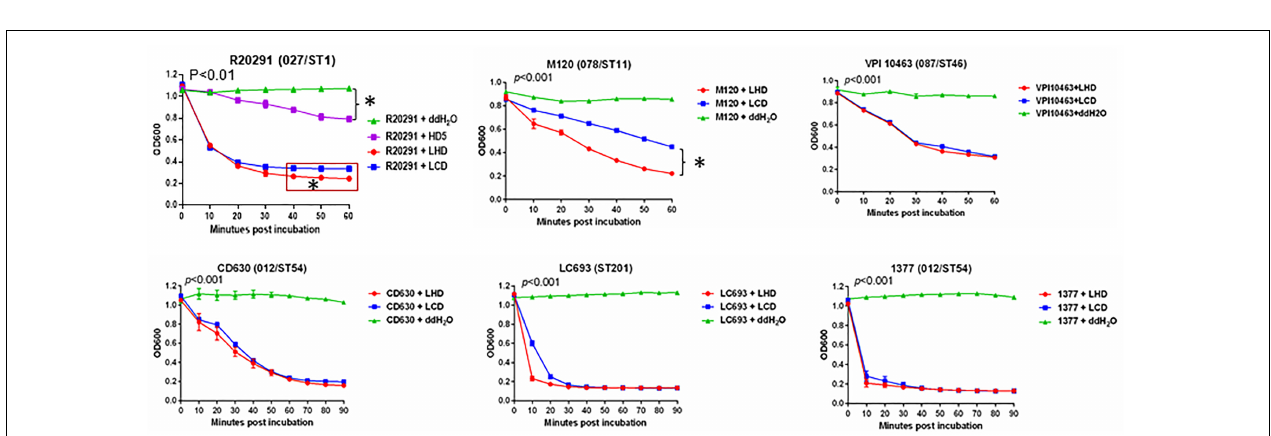
FIGURE 2 | Purification of protein LHD and LCD. (A) SDS-PAGE analysis of protein LHD induced and expressed in cell pellet (as inclusion bodies) (Lane 1) and supernatant (soluble form) (Lane 2) at 15 ◦ C, overnight. (B) SDS-PAGE analysis of protein LCD induced and expressed in cell pellet (as inclusion bodies) (Lane 1) and supernatant (soluble form) (Lane 2) at 37 ◦ C for 3 h. (C) SDS-PAGE gel analysis of purified LHD and LCD.